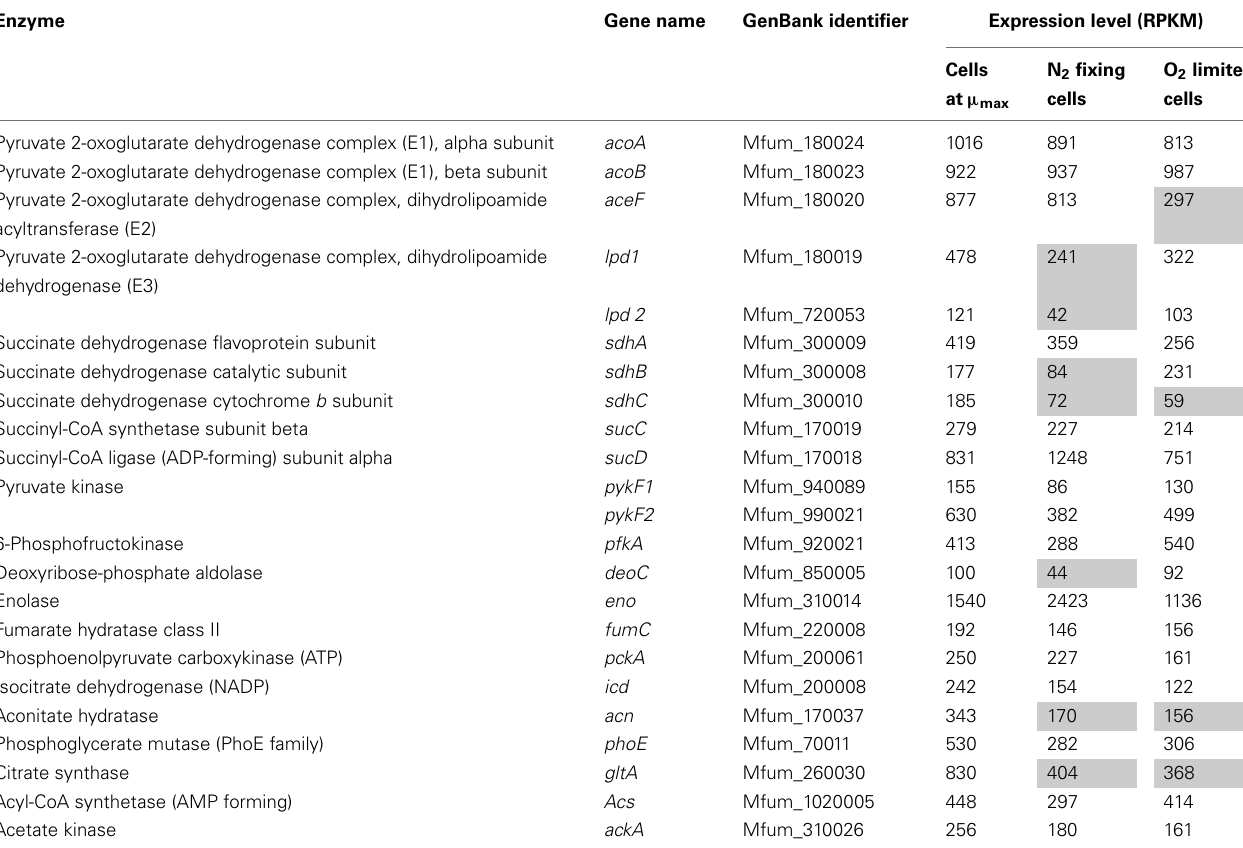
TableA2 |Transcription of genes involved theTCA cycle in “ Ca. M. fumariolicum ” strain SolV.